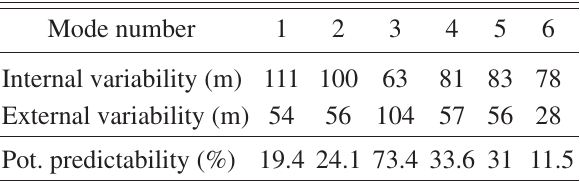
Table IV. Same as in table III, but for the experiment NOATL. The 99% significance level is reached when potential predictability is 6.34%.